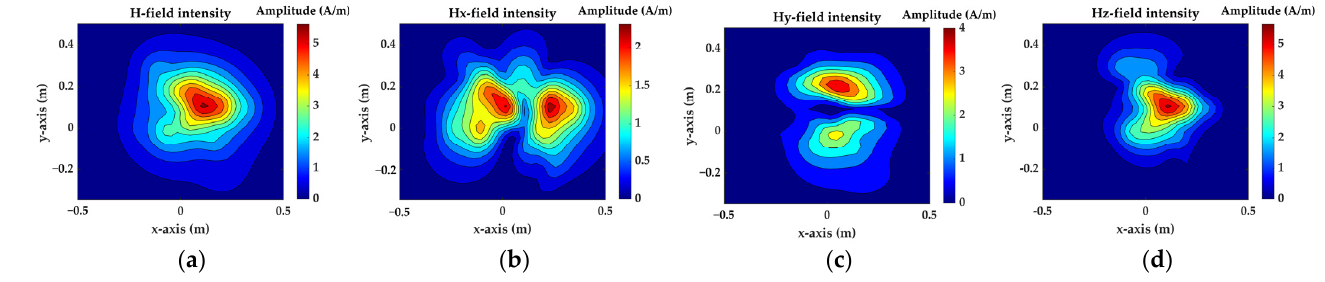
Figure 9. The distribution of magnetic field intensity is calculated by the equivalent magnetic dipole array. ( a ) The amplitude distribution of H; ( b ) The amplitude distribution of Hx; ( c ) The amplitude distribution of Hy; ( d ) The amplitude distribution of Hz. Table 2. Relative errors of magnetic field obtained by method of this article.